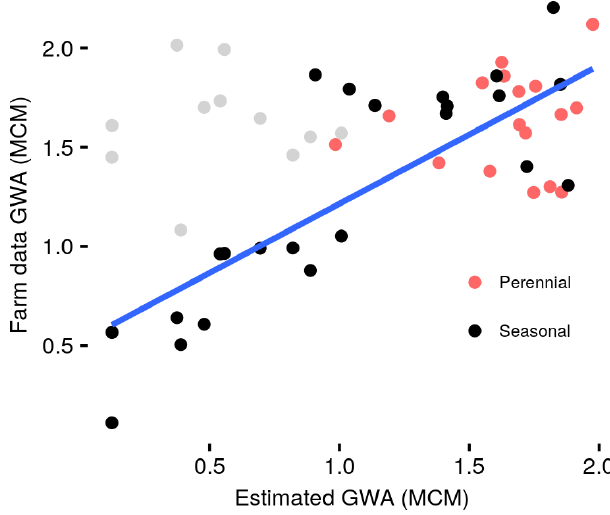
Figure 5. Comparison of annual groundwater estimates to farm data. The blue line shows the regression based on the black and green dots (adjusted to include only active seasons for 11 seasonal fields). The gray points show the original farm data with long pre- planting stages for those same 11 seasonal